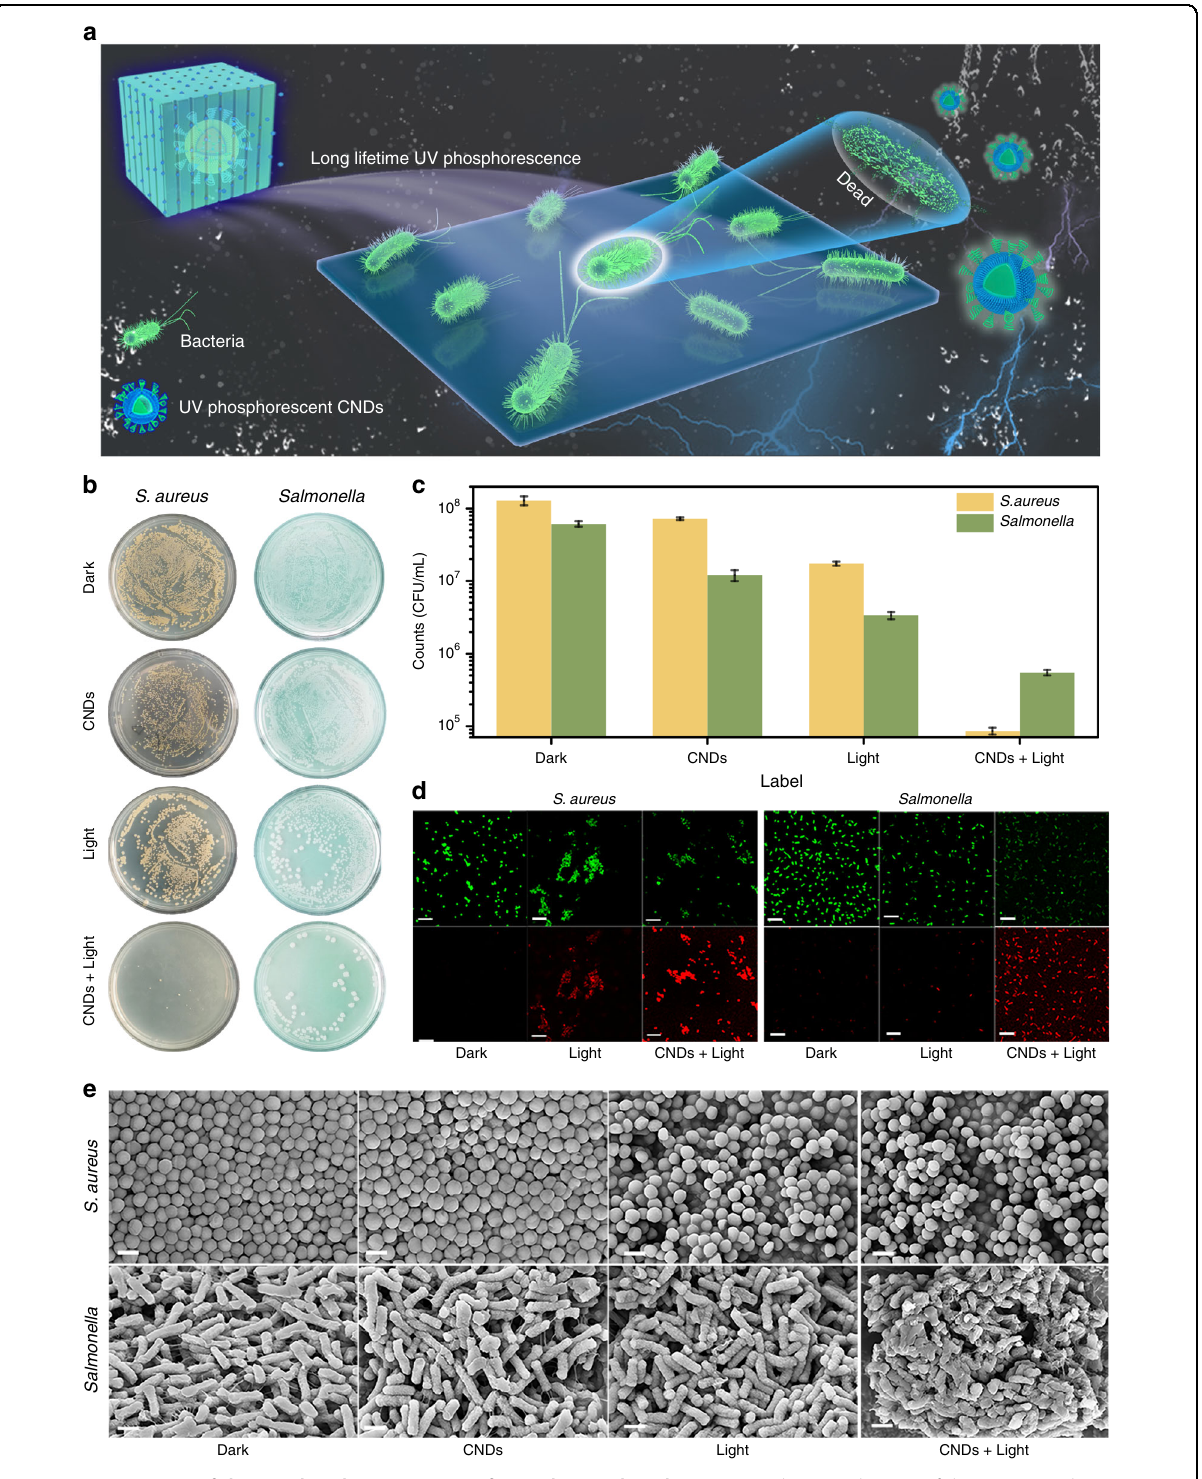
Fig. 4 Demonstration of the UV phosphorescent CNDs for antibacterial applications. a Schematic diagram of the interaction between UV phosphorescence and bacteria. b Images of the fl at colony counting results under different conditions. c Number of bacterial counts (CFU mL − 1 ) in panel ( b ). d CLSM images of S. aureus and Salmonella after treatment with CNDs-2@NaCNO under excitation of pulsed light for fi ve cycles (one cycle: irradiation six times within 1 min, excitation light: 310 nm, 7 mW cm − 2, 0.1 Hz); scale bar is 20 µm. e SEM images of the S. aureus and Salmonella under different conditions; scale bar is 1 μ